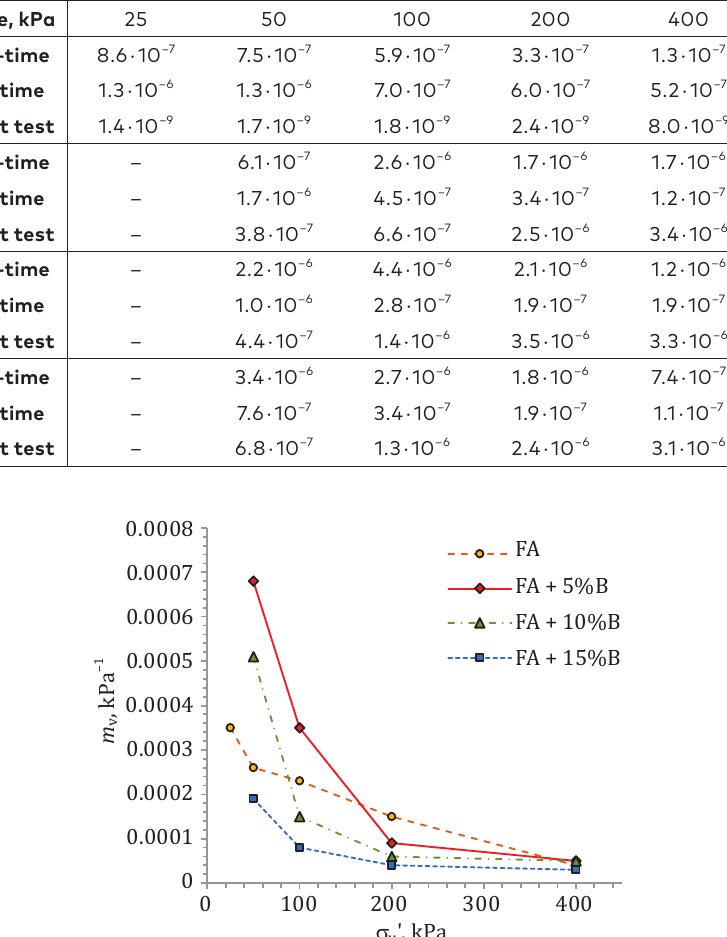
Table 4. Values of coefficient of consolidation c v of tested materials derived